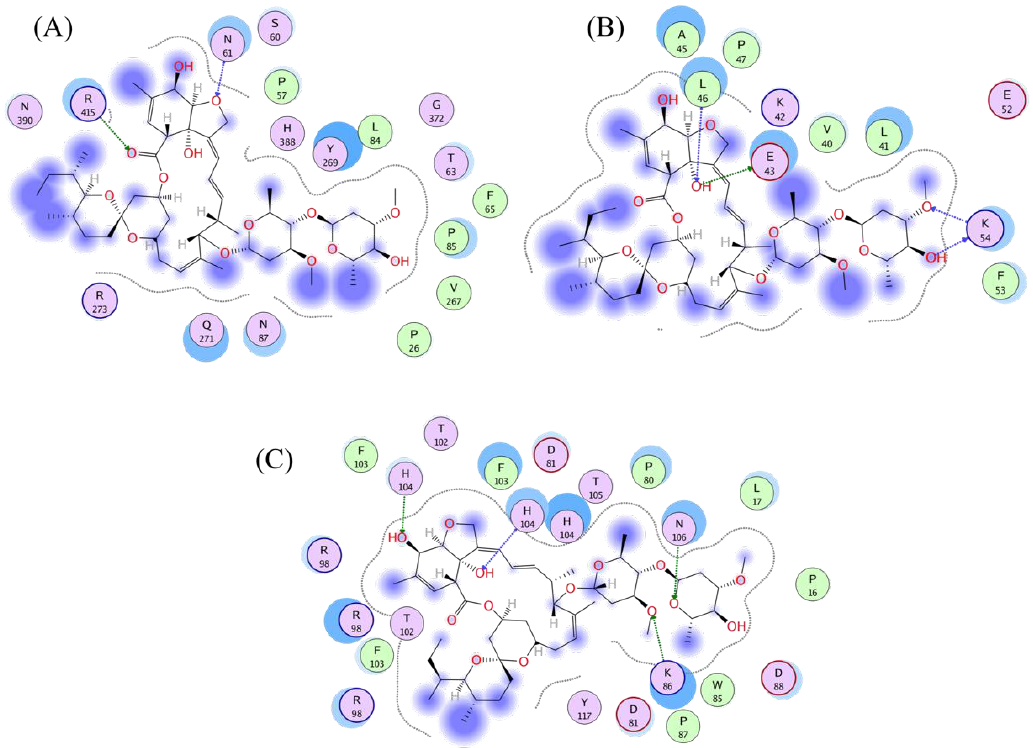
Figure 5. Ligand interaction plots of ivermectin for ( A ) spike, ( B ) CD147 and ( C ) α7nAChr